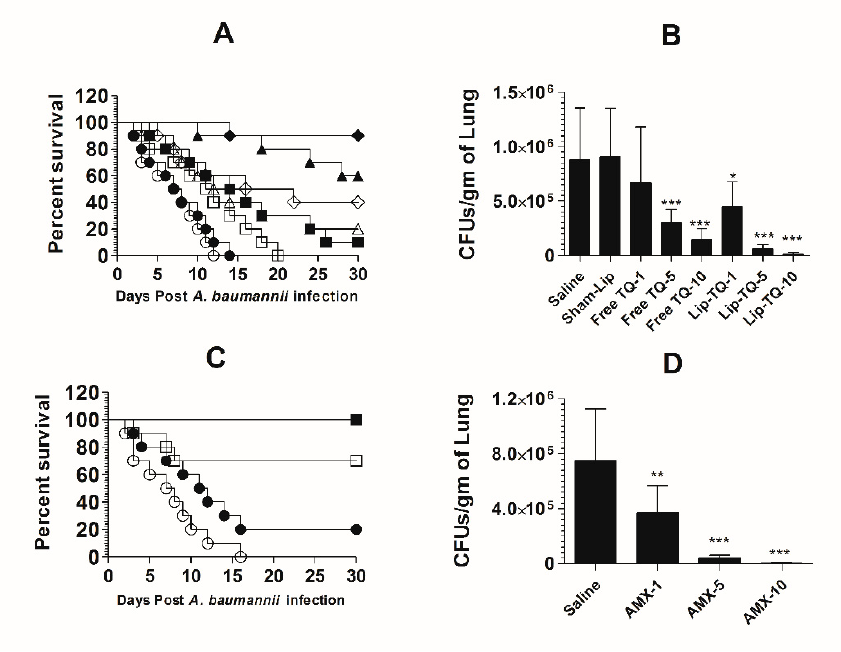
Figure 8. Lip-TQ or AMX effectively eliminated the drug-sensitive A. baumannii infection in a murine model. ( A ) Each mouse was infected with 1 × 10 7 CFUs of A. baumannii through an intravenous dose. After 12 h of the infection, the mice were treated with 1, 5 and 10 mg/kg of free TQ and Lip-TQ for seven consecutive days. The mice were monitored for 30 days for the survival. Saline